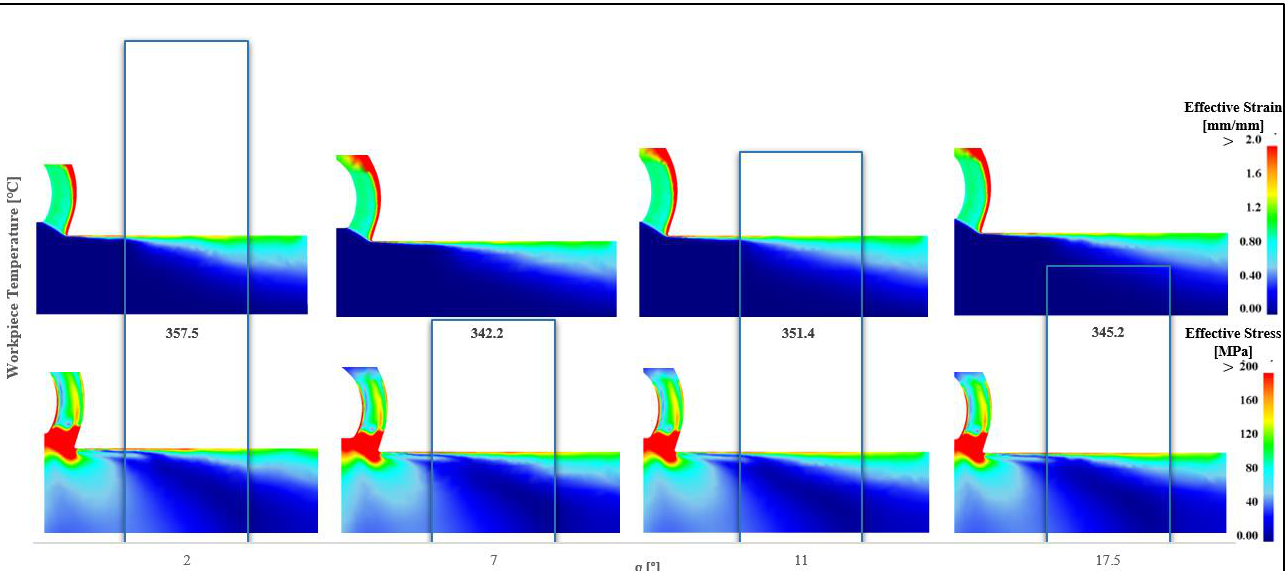
Figure 21. Maximum workpiece temperature strain–stress simulation with respect to the clearance angle.